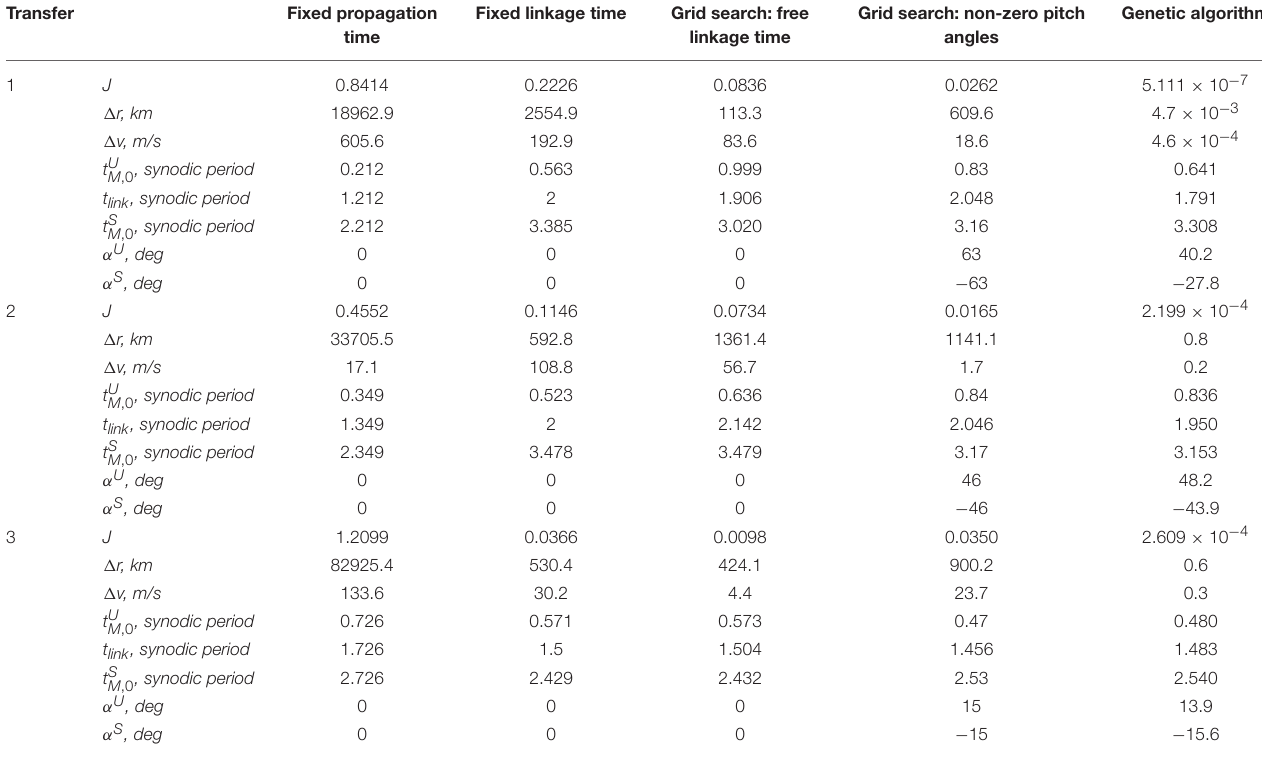
TABLE 2 | Objective value, dimensional errors on position and velocity, and further details for transfers 1–3 for different approaches in the search for homoclinic connections.